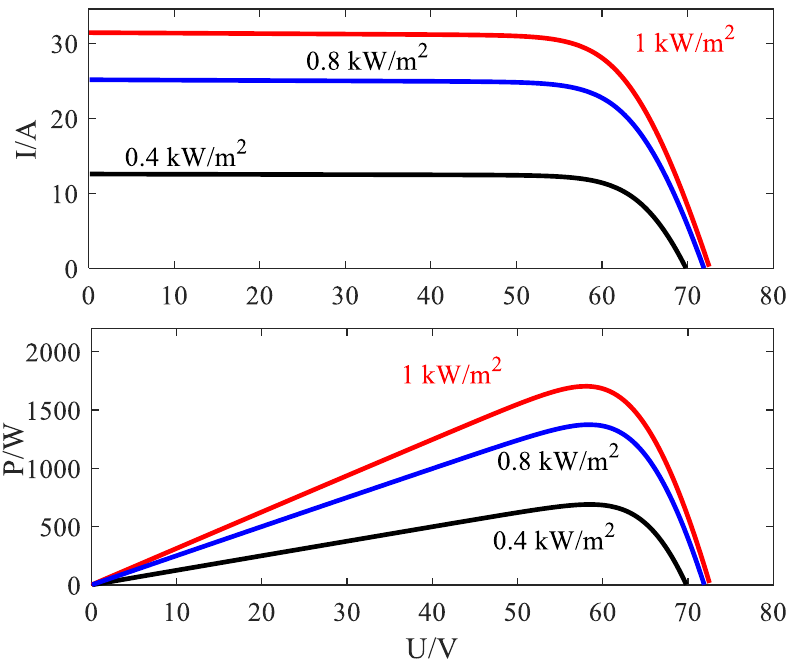
Figure 2. Output characteristics of photovoltaic cells under uniform radiance. Radiance and temperature are the two main factors of the PV system [11,40]. Pho- tovoltaic cells are equated as power supply, and the circuit model also contains diode, resistance and load. The whole circuit is displayed in schematic form in Figure